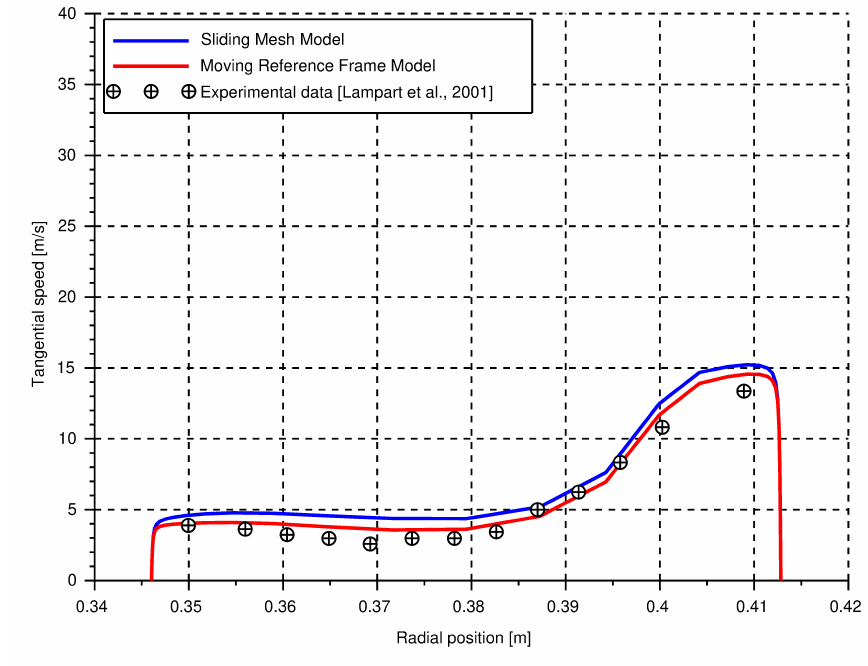
Figure 8. Experimental data Comparison of computed and experimental radial distribution of absolute tangential speed at 135% of the axial chord downstream of the rotor trailing